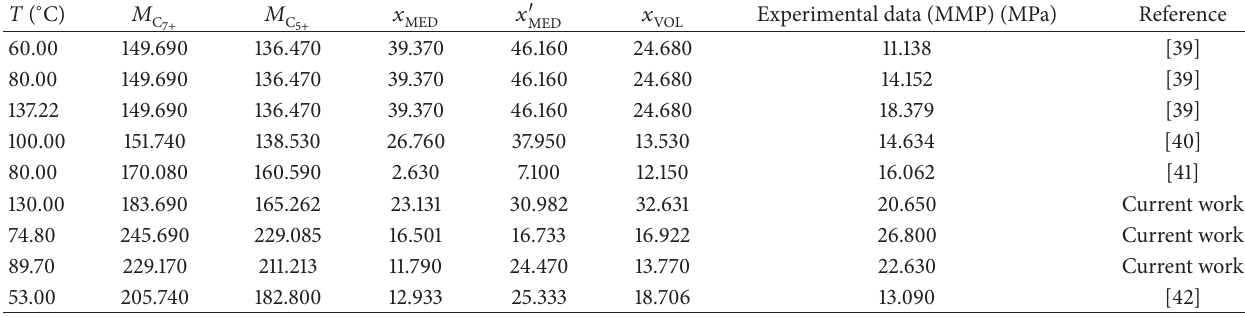
Table 4: The nine oil samples components, properties, and MMP data for the new correlation validation.